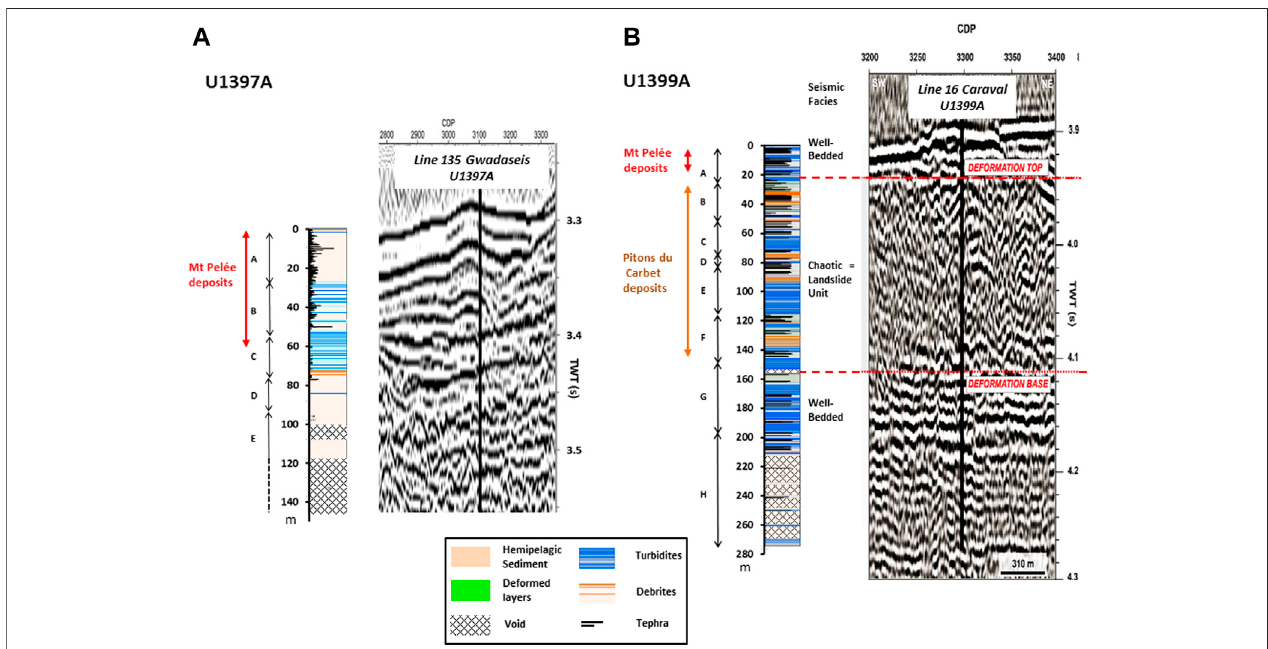
FIGURE3| Simpli fi edlithology,deformation fi gures,andseismicfaciesofholes1397A (A) and1399A (B) .SeismicdatafromBrunetetal.(2016)andLeFriantetal. (2015), Le Friant et al.(2020). Depth in core in meter. Letters: lithological units de fi ned on board (Le Friant et al., 2013). The reader is referred to Supplementary Figure S1 for high-resolution stratigraphic logs on the web version of this article for bene fi t.